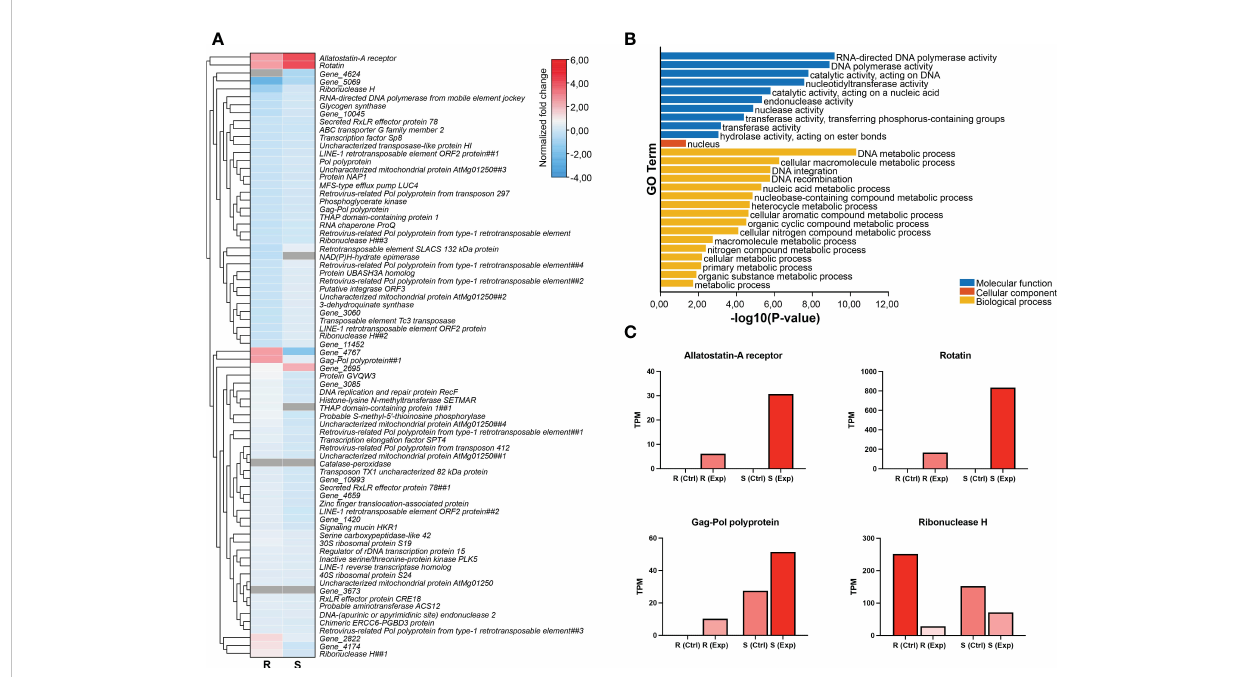
FIGURE 6 Expression analyses of genes containing CNVs in the resistant vs. susceptible strains comparison. (A) Hierarchical clustering of fold change values (obtained from exposed vs. control comparison for each strain) based on Manhattan ’ s distances with an average linkage. R: the resistant strain; S: the susceptible strain. (B) GO Enrichment for the genes containing CNVs in the resistant vs. susceptible comparison. (C) selection of particular genes of interest with signi fi cant changes in TPM